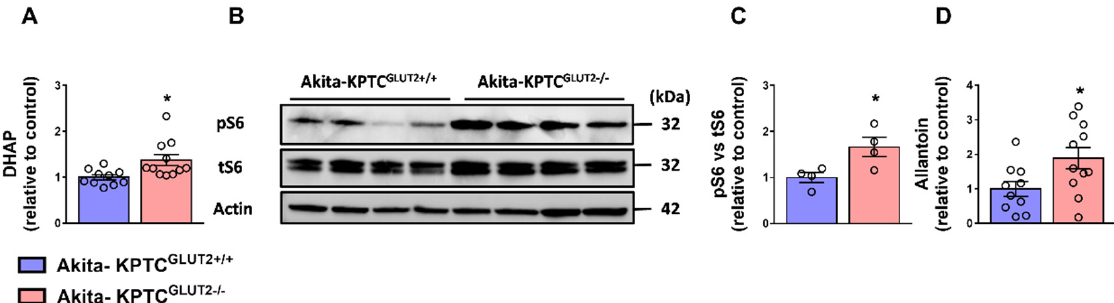
Figure 5. DHAP upregulation and mTORC1 activation in Akita-KPTC GLUT2 − / − mice. Significant DHAP upregulation in Akita-KPTC GLUT2 − / − mice (n = 11), compared with Akita-KPTC GLUT2+/+ mice (n = 10) ( A ). Enhanced mTORC1 activation in Akita-KPTC GLUT2 − / − kidneys, manifested by the elevated protein expression levels of pS6, shown in a representative immunoblot ( B ) and quantification (n = 4 mice for each group) ( C ). Significant allantoin upregulation, an oxidative stress biomarker, in Akita-KPTC GLUT2 − / − mice (n = 11), compared with Akita-KPTC GLUT2+/+ mice (n = 10) ( D ). Data represents the mean ± SEM and were analyzed by Unpaired Two-tailed Student’s t -test. * p < 0.05. DHAP, Dihydroxyacetone Phosphate.